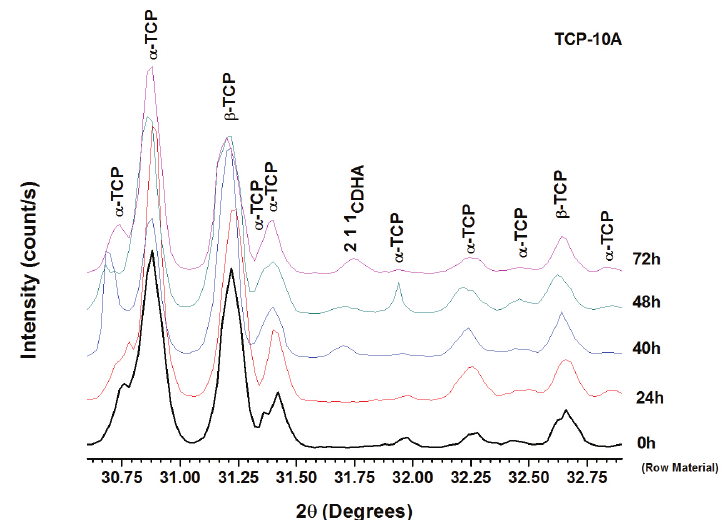
Figure 3. XRD patterns of TCP-10A under in-situ setting condition within 72